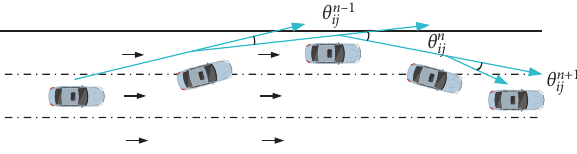
Figure 3: Vehicle instantaneous angular displacement.